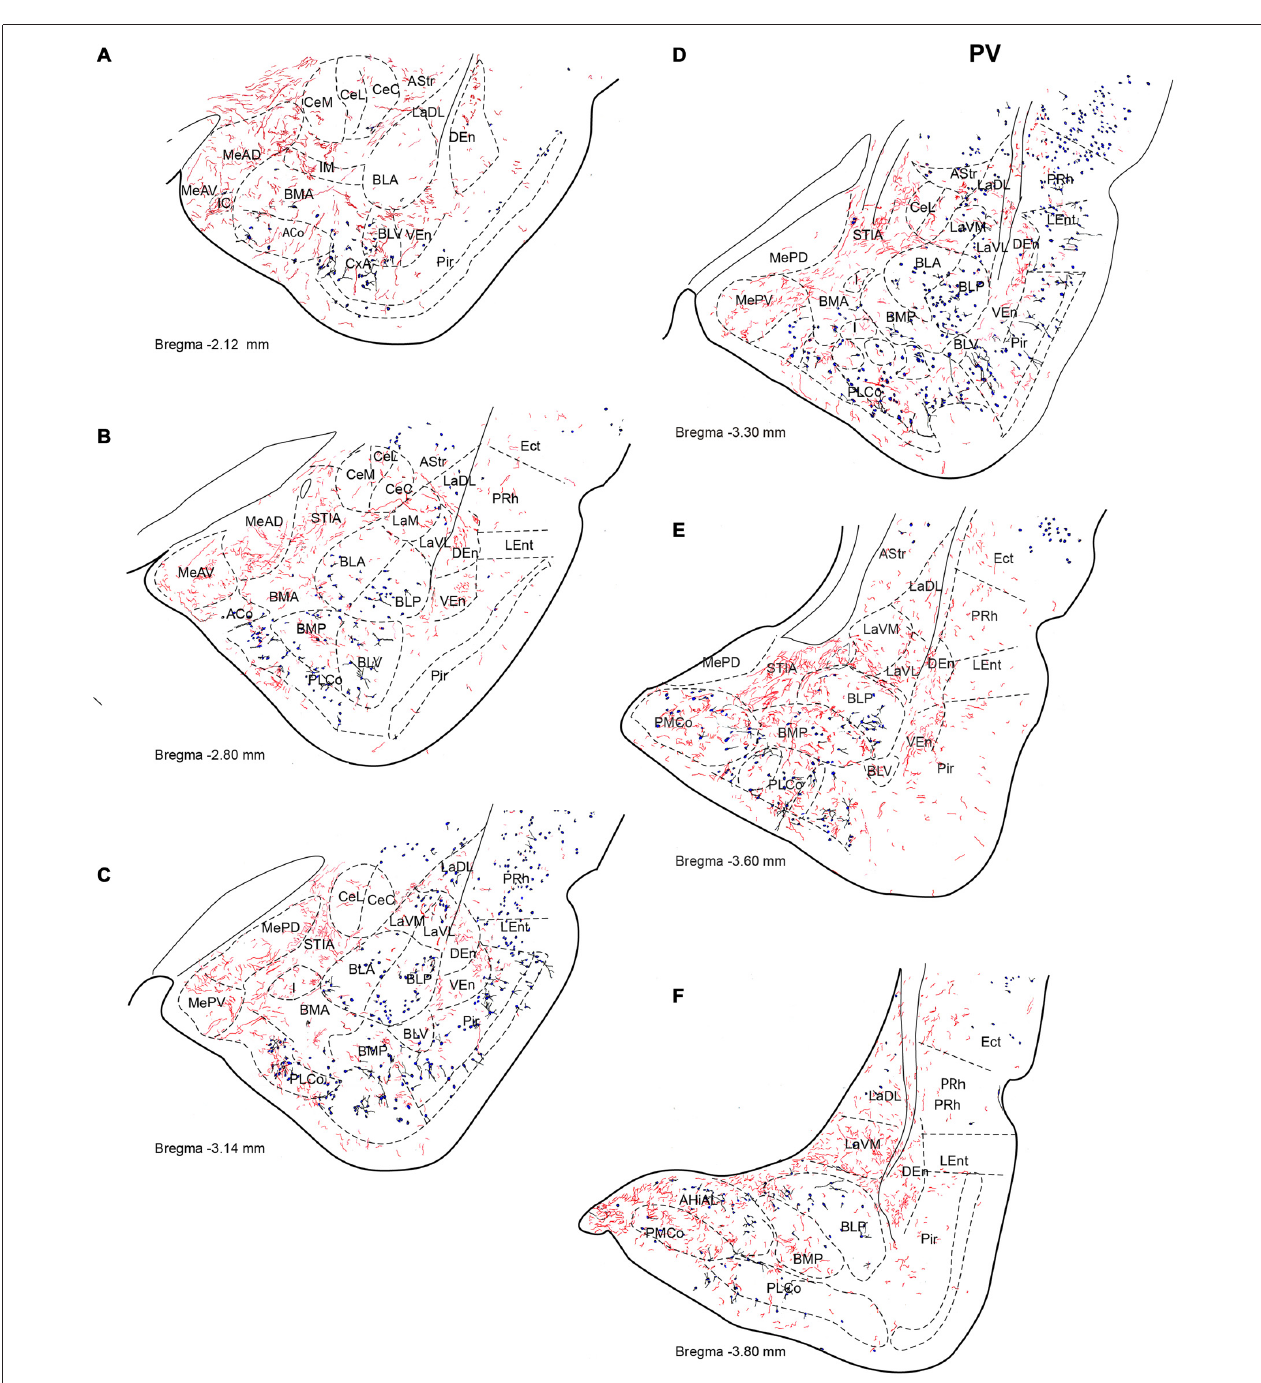
FIGURE 5 | Distribution of relaxin-3-positive fibers in the TA relative to the distribution of parvalbumin (PV)-positive neurons . Relaxin-3 fibers located in the medial amygdala areas containing a lower proportion of PV neurons. (A–F) Camera lucida drawings of the corresponding Bregma levels. Calibration bar 250 µ m.